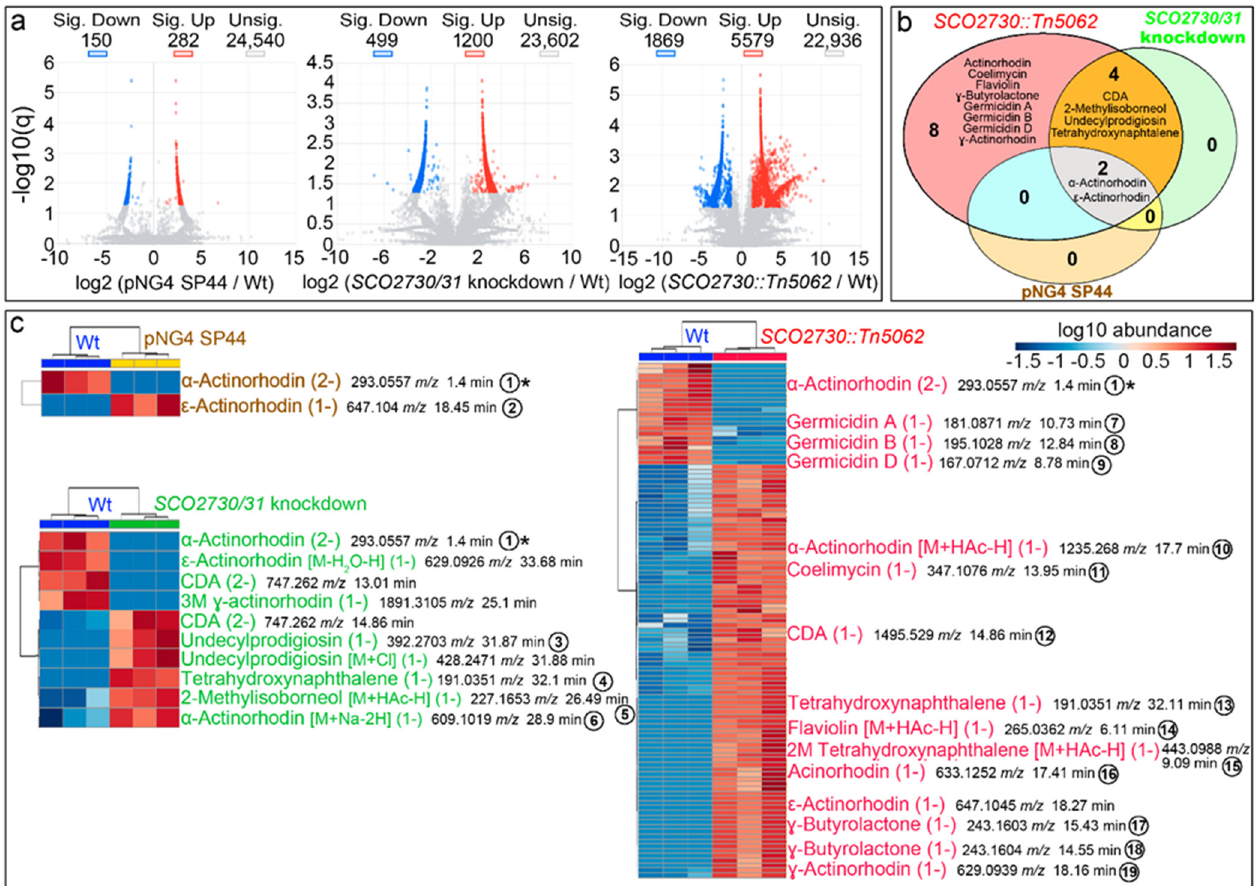
Figure 3. Metabolome analysis of the S. coelicolor SCO2730::Tn5062 and the SCO2730/31 knockdown mutants compared to the S. coelicolor wild-type strain with and without pNG4-SP44. ( a ) Volcano plots of the abundance values of the compounds detected in each strain compared to the wild-type strain. Significant up- (red) and down-regulated (blue) compounds are indicated. ( b ) Venn diagram showing the putatively identified secondary metabolites, showing significantly affected pro- duction in the SCO2730::Tn5062 mutant, the SCO2730/31 knockdown mutant and the pNG4-SP44 strains compared to the wild-type strain. ( c ) Heat-map showing the abundance values of putatively identified secondary metabolite adducts and isomers showing significant differences compared to the wild-type strain. The abundance values from three biological replicates are shown. The numbers indicate compounds detected in only one of the samples, whose chromatograms are indicated in Figure 4. The asterisk indicates the only compound identified in all the strains that was significantly down- regulated compared to the wild-type strain.